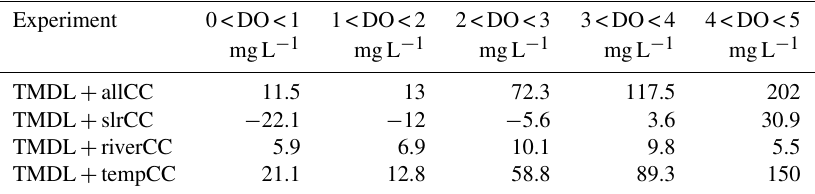
Table 5. Percent ∗ of 3-year average bottom DO change as a result of the temperature experiment due to solubility for each region at the surface and bottom of the water column. Region Surface Bottom